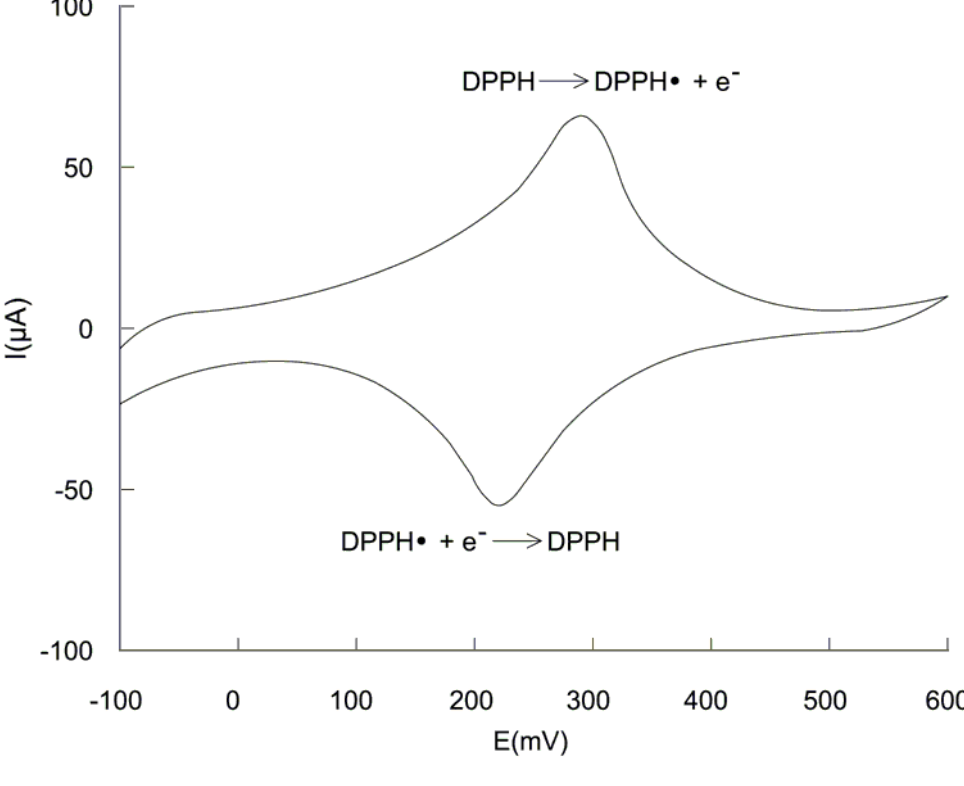
Figure 3 . Cyclic voltammogram obtained for the DPPH·/DPPH redox couple; conditions: DPPH· concentration = 0.5 mM; DPPH concentration = 0.5 mM; potential sweep speed = 50 mV/s; (for details see